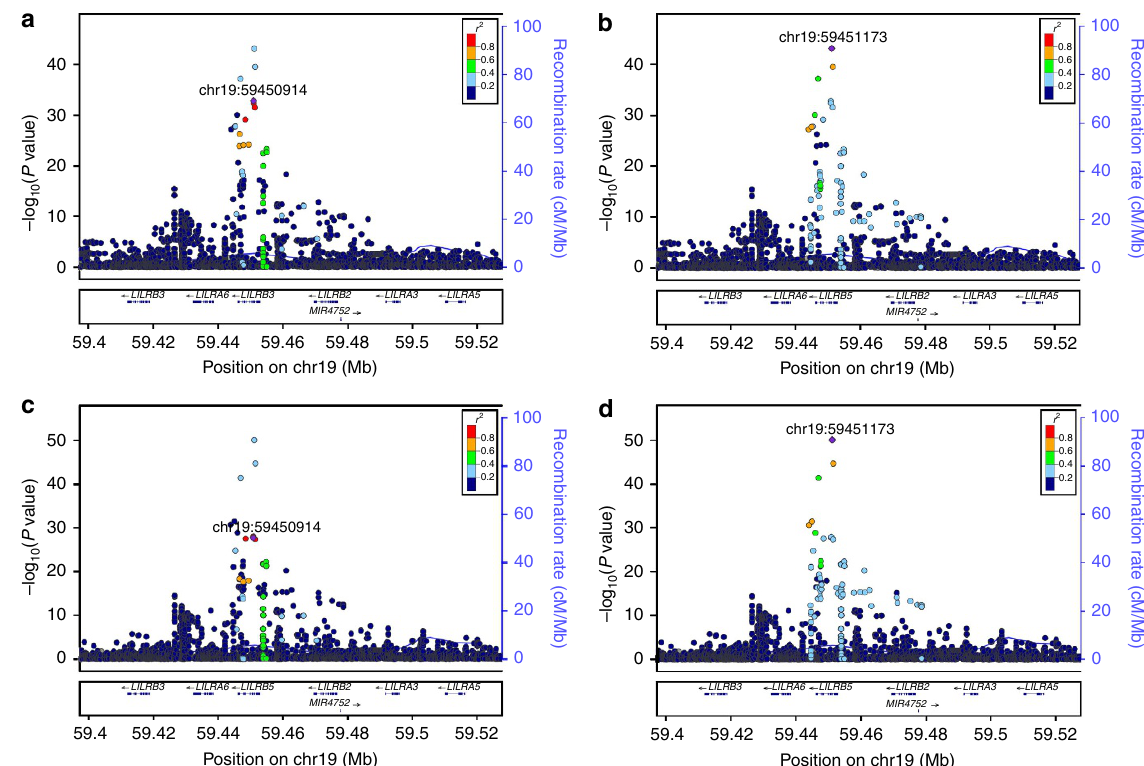
Figure 3 | Locus plots depicting variants at the LILRB5 locus associating with serum enzyme levels. Leading variants are labelled and shown in purple, other variants are coloured according to correlation ( r 2 ) with the leading marker (legend at top-right). (cid:3) log 10 P values are shown along the left y axis and correspond to the variants depicted in the plot. The right y axis shows calculated recombination rates at the chromosomal location, plotted as a solid blue line. ( a ) Association between the signal represented by rs393600 and serum CK levels. ( b ) Association between the signal represented by rs12975366 and serum CK levels. ( c ) Association between the signal represented by rs393600 and serum LDH levels. ( d ) Association between the signal represented by rs12975366 and serum LDH